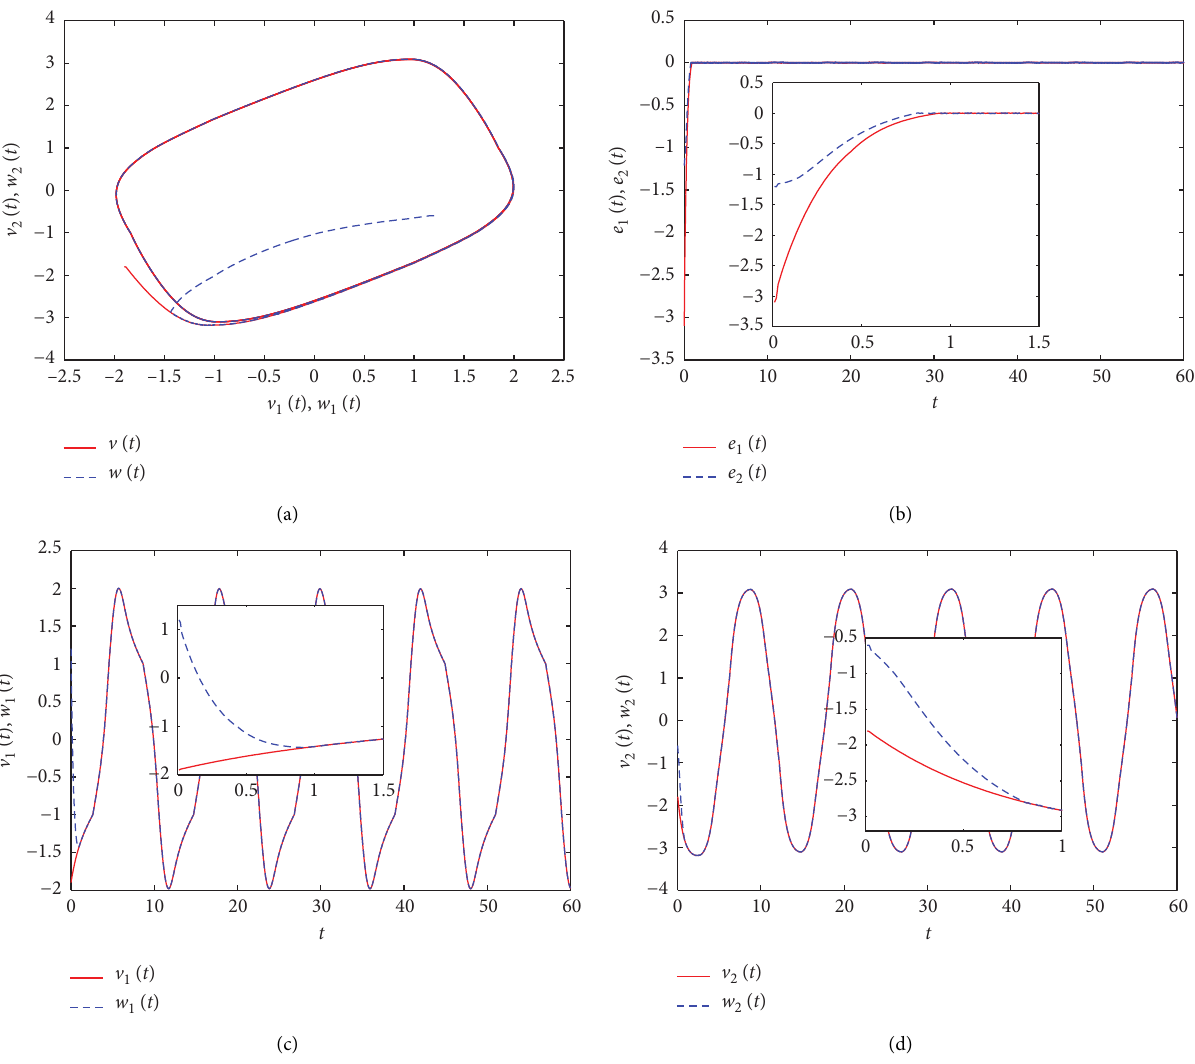
Figure 3: The chaotic behaviors, error and state trajectories of the derive FOMNN (46), and the response FOMNN (8) with the state feedback controller u